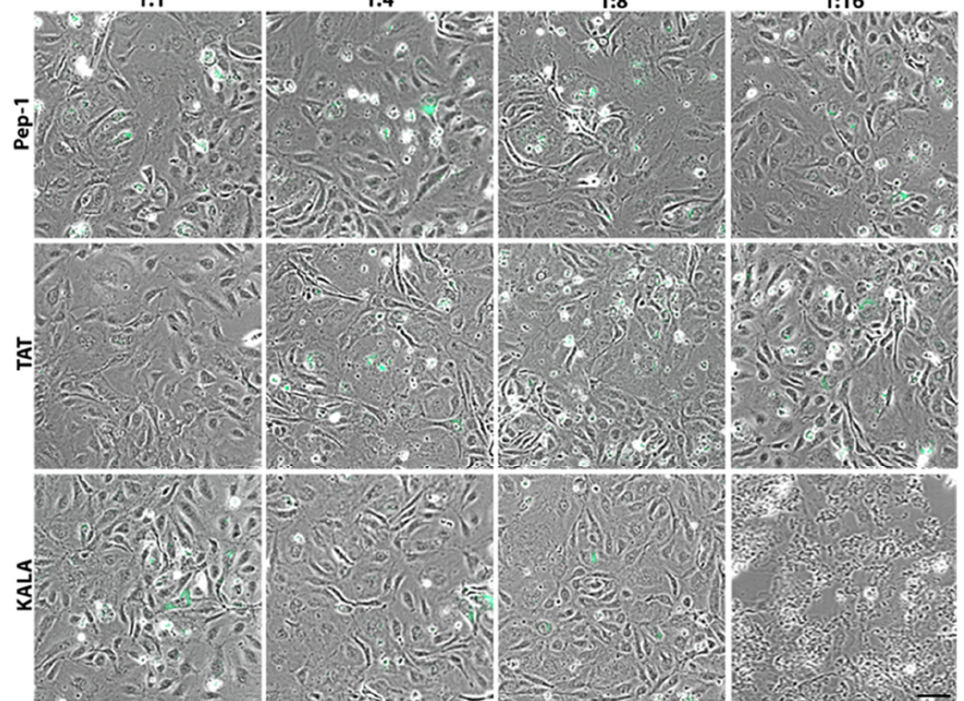
Figure 4. Results of 48 h culture in the presence of complexes in CRs of 1:1, 1:4, 1:8 and 1:16. The complexes were formed using incubation of 1 μ g pmaxGFP with chosen CPPs at 21 °C for 15 min. Bar = 50 μ m. CR, charge ratio.